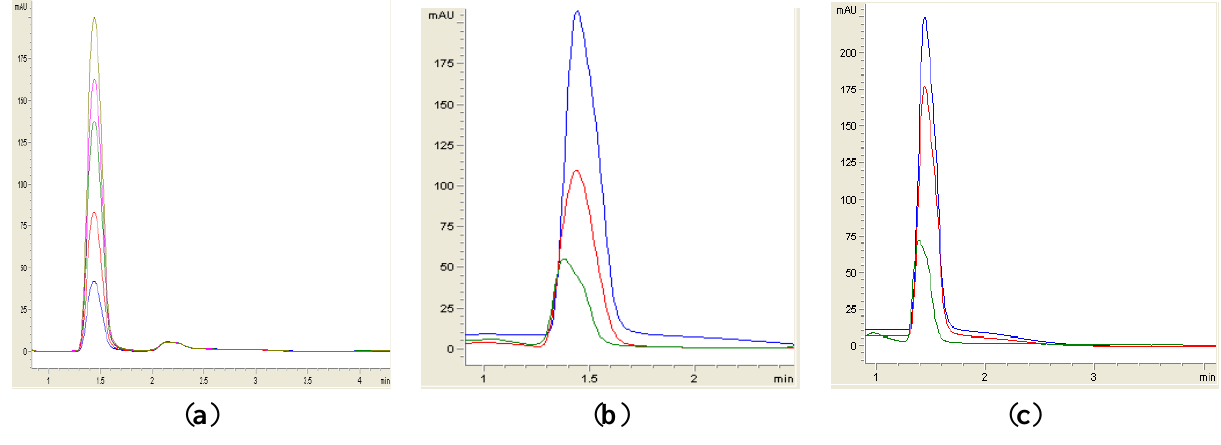
Figure 3. RRLC analysis of C6-HSL degradation. Residual C6-HSL (with elution time of 1.50 min ± 1.2 s), after degradation for 0 h (blue), 24 h (green) and relactonisation with HCL (red) was monitored at 210 nm. Degradation of C6-HSL is depicted by the reduction of milli-absorbance units (mAU) in the chromatogram. ( a ) Synthetic C6-HSL was used at 0.2. 0.4, 0.6, 0.8 and 1.0 µg/µL as standards (corresponding to peaks with ascending height); ( b ) isolate B2; ( c ) isolate B3; ( d ) B. cereus as positive control; both ( e ) E. coli TOP10; and ( f ) PBS buffer acted as the negative controls. Degradation and relactonisation of C6-HSL was observed by both the B2 and B3